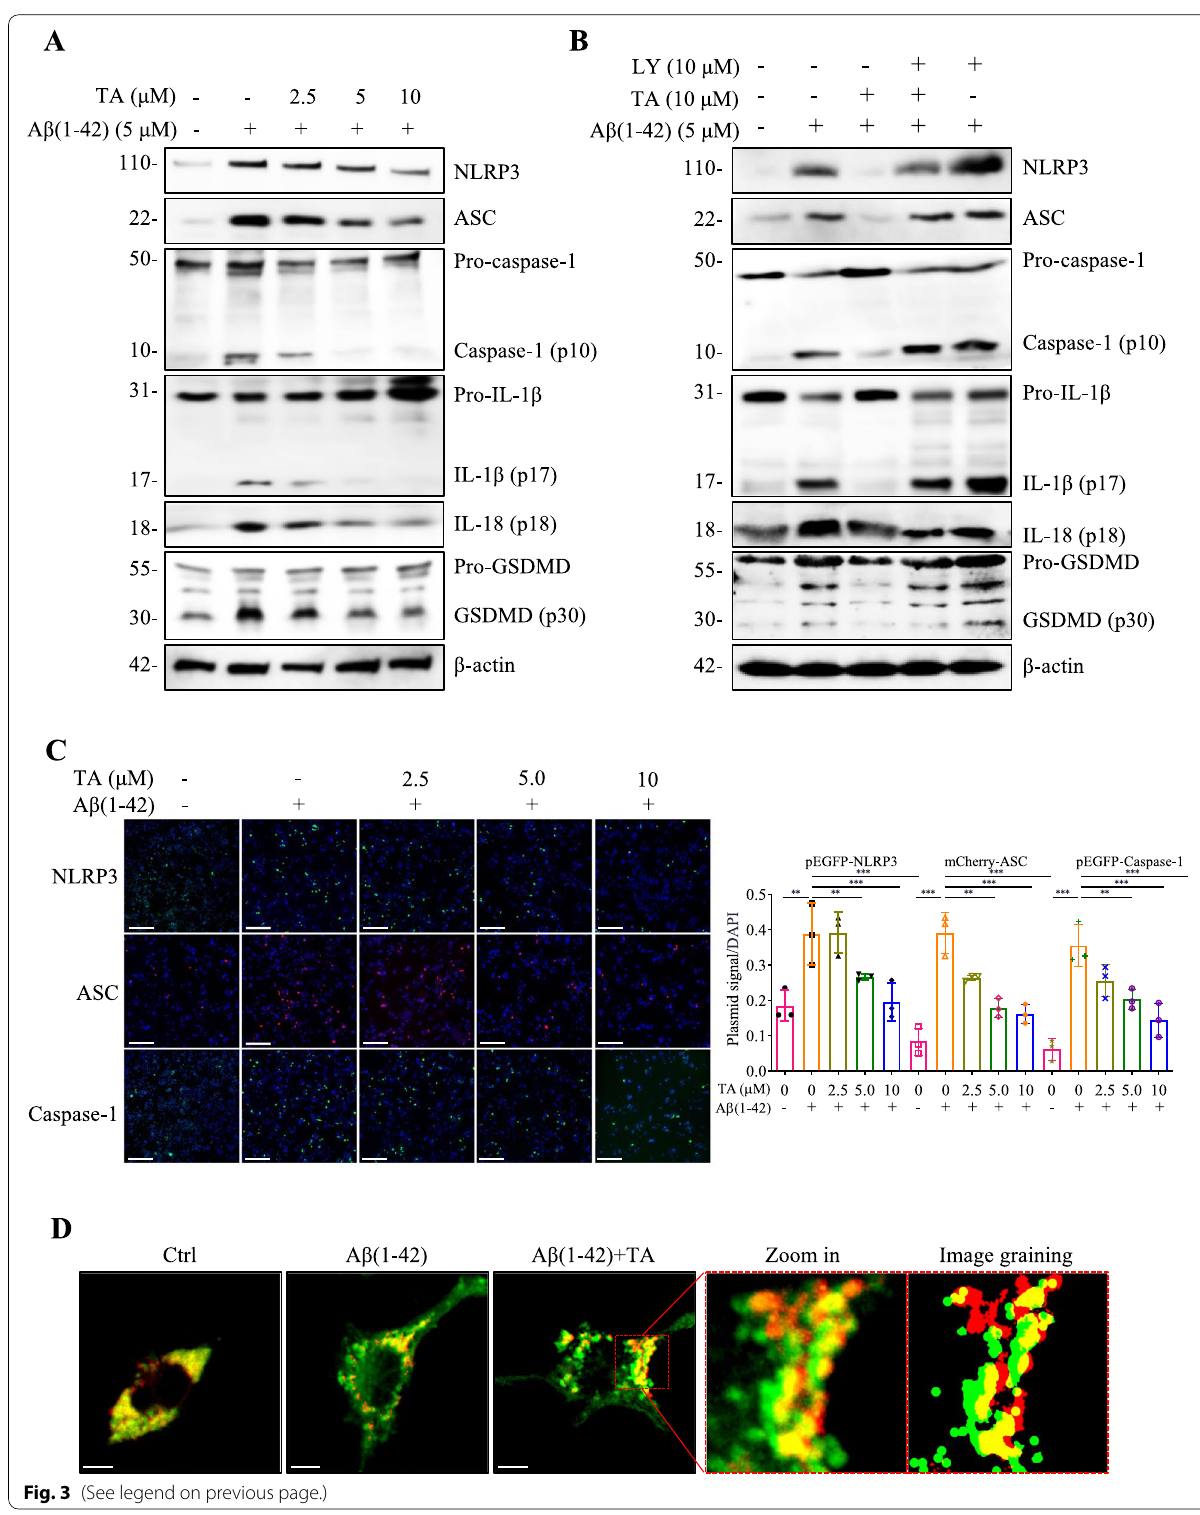
Fig. 3 (See legend on previous